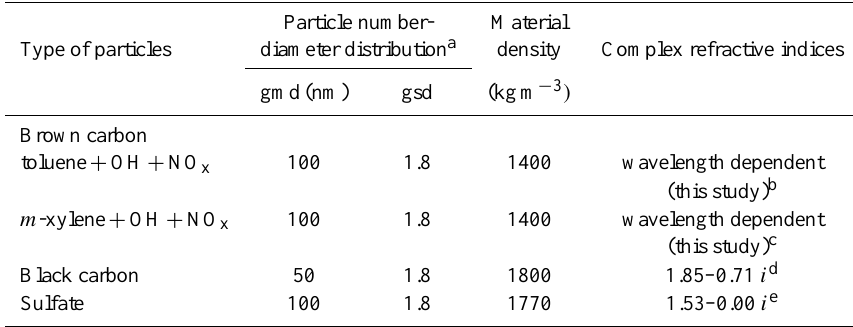
a Parameters describing a single-mode log-normal number–diameter distribution for the governing